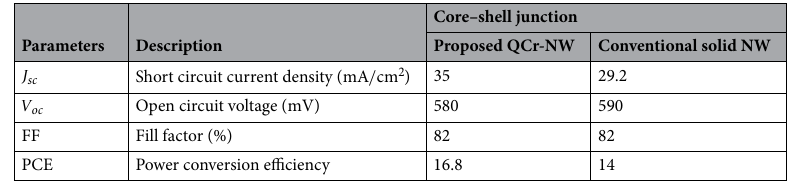
Table 3. The PCE for the initial core–shell junctions of the QCr-NW and the conventional NW structures.